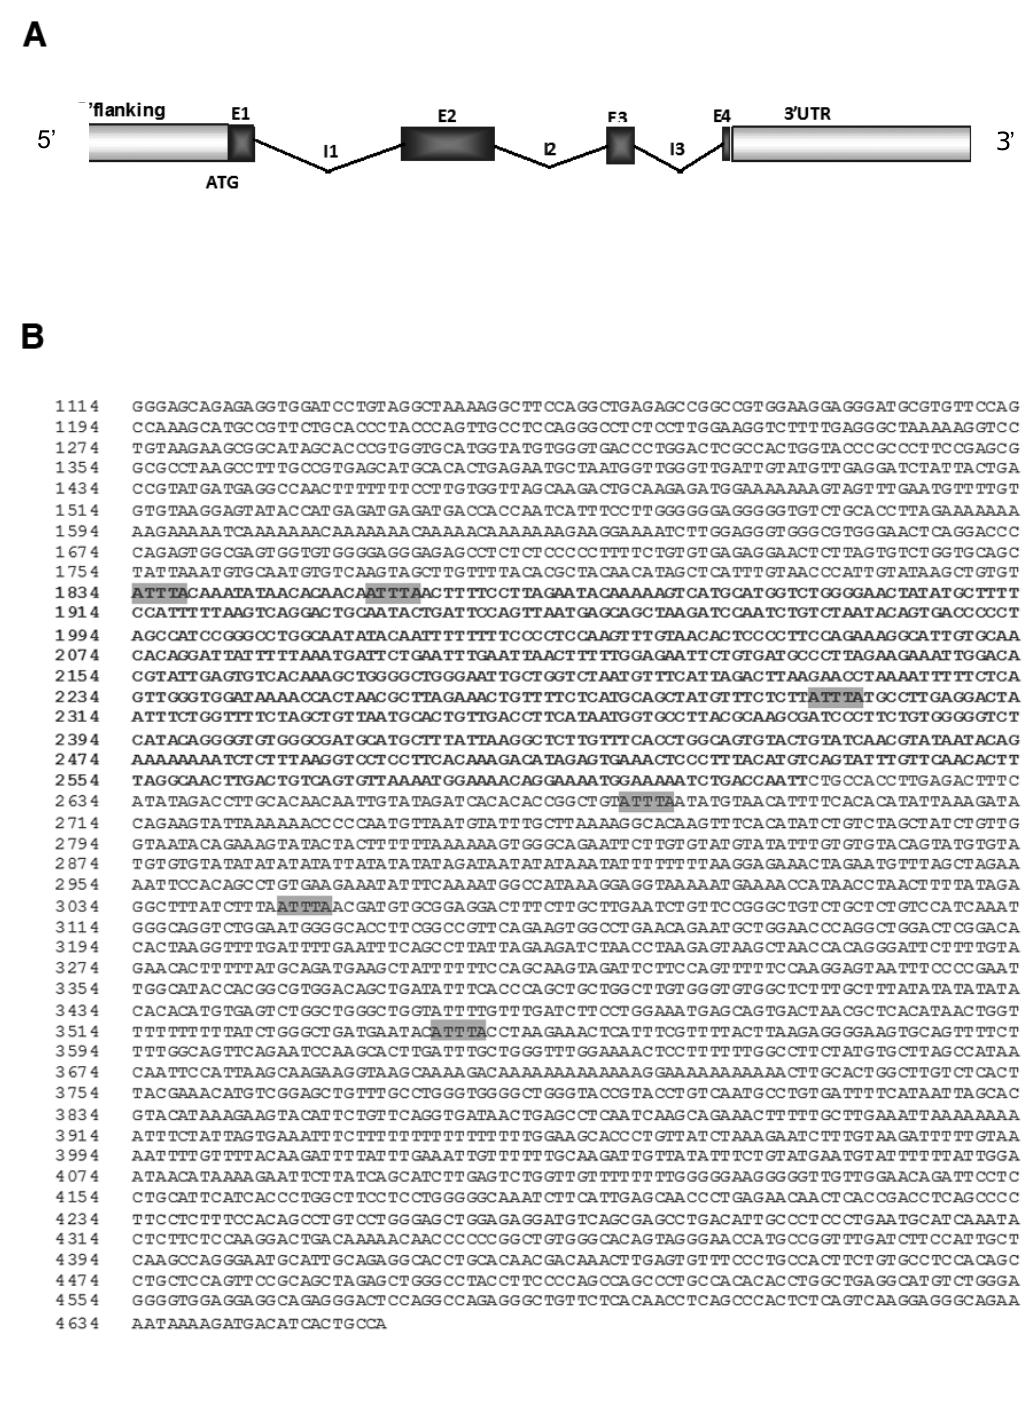
Figure 1. Organization of the KLF6 gene. ( A ) Schematic representation of the KLF6 gene, including untranslated regions (UTR), introns (I) and Exons (E); ( B ) Bioinformatic analysis of KLF6 UTR for AU-rich Elements (highlighted in grey). KLF6 UTR segment #2 is highlighted in bold. AU-rich elements were identified using [23].